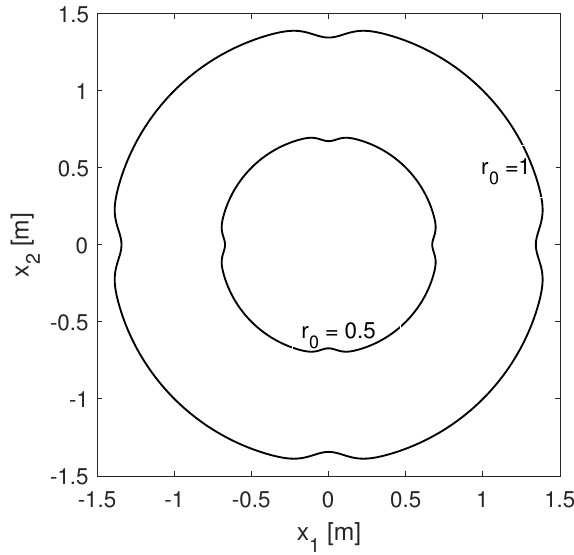
Figure 5. Representation of the curve Γ for r 0 = 0.5 and r 0 =